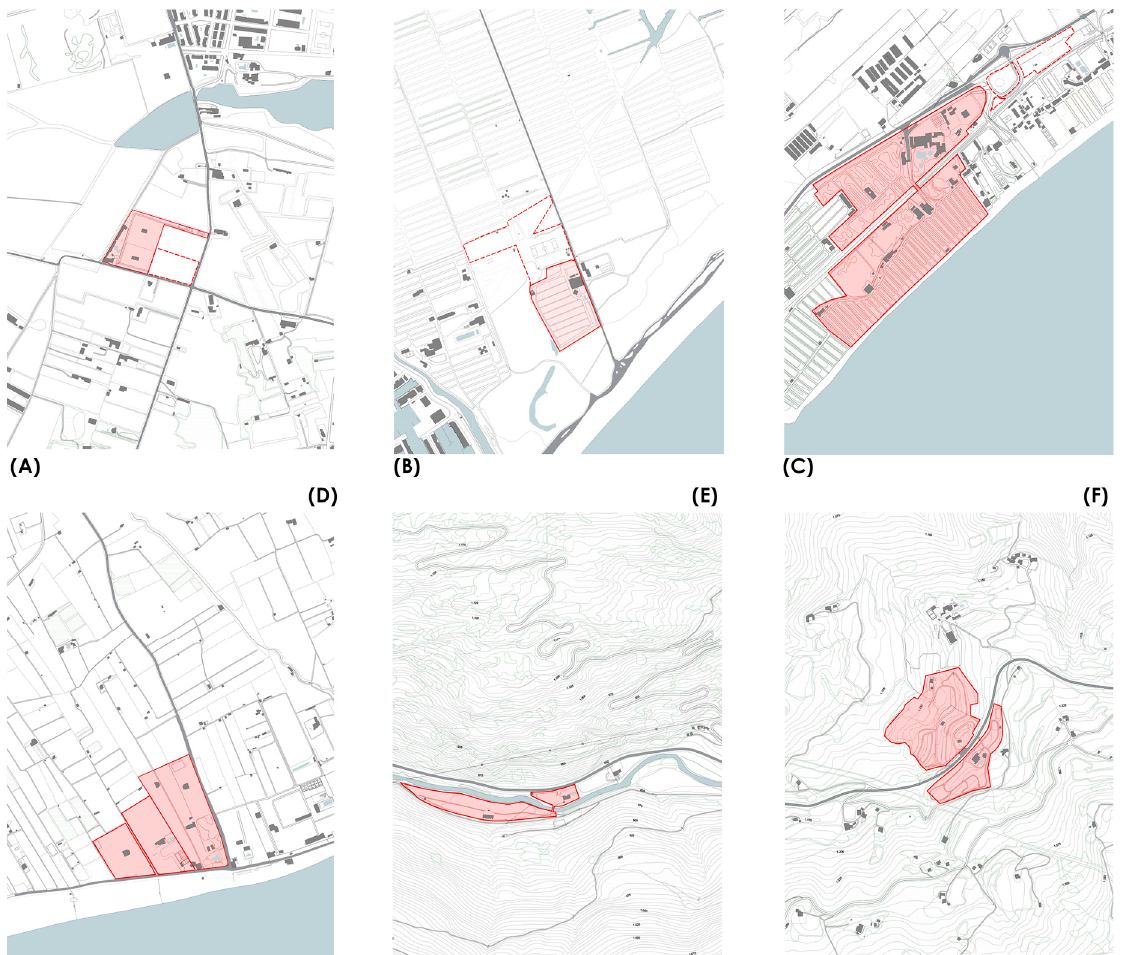
Figure 5. Location plans and landscape values. Scale 1/5000, DinA3, vertical north (Source: authors’ own). ( A ) Campsite Les Medes; ( B ) Campsite Castell Mar; ( C ) Campsite Torre del Sol; ( D ) Campsite Pla de Mar; ( E ) Campsite Verneda; ( F ) Campsite Rep ò s